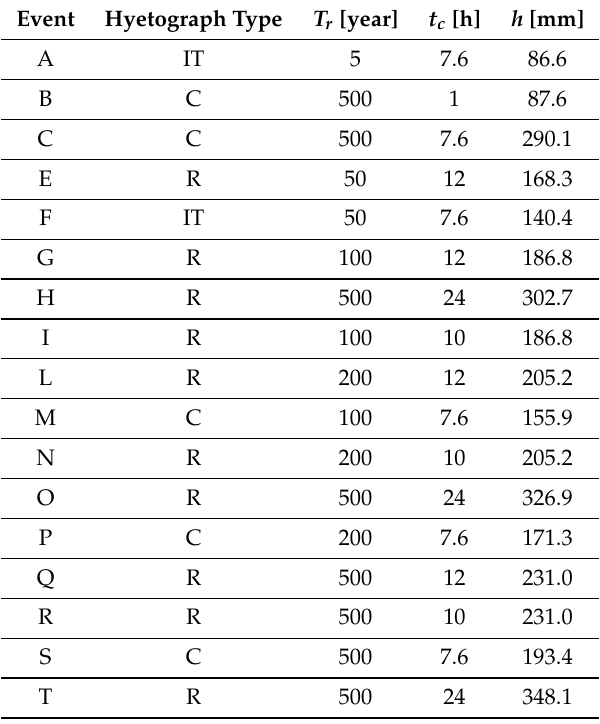
Table 2. Main characteristics of the hyetographs for the inventory of sample rainfall-runoff events used for the test case in the Corace watershed (Calabria, Southern